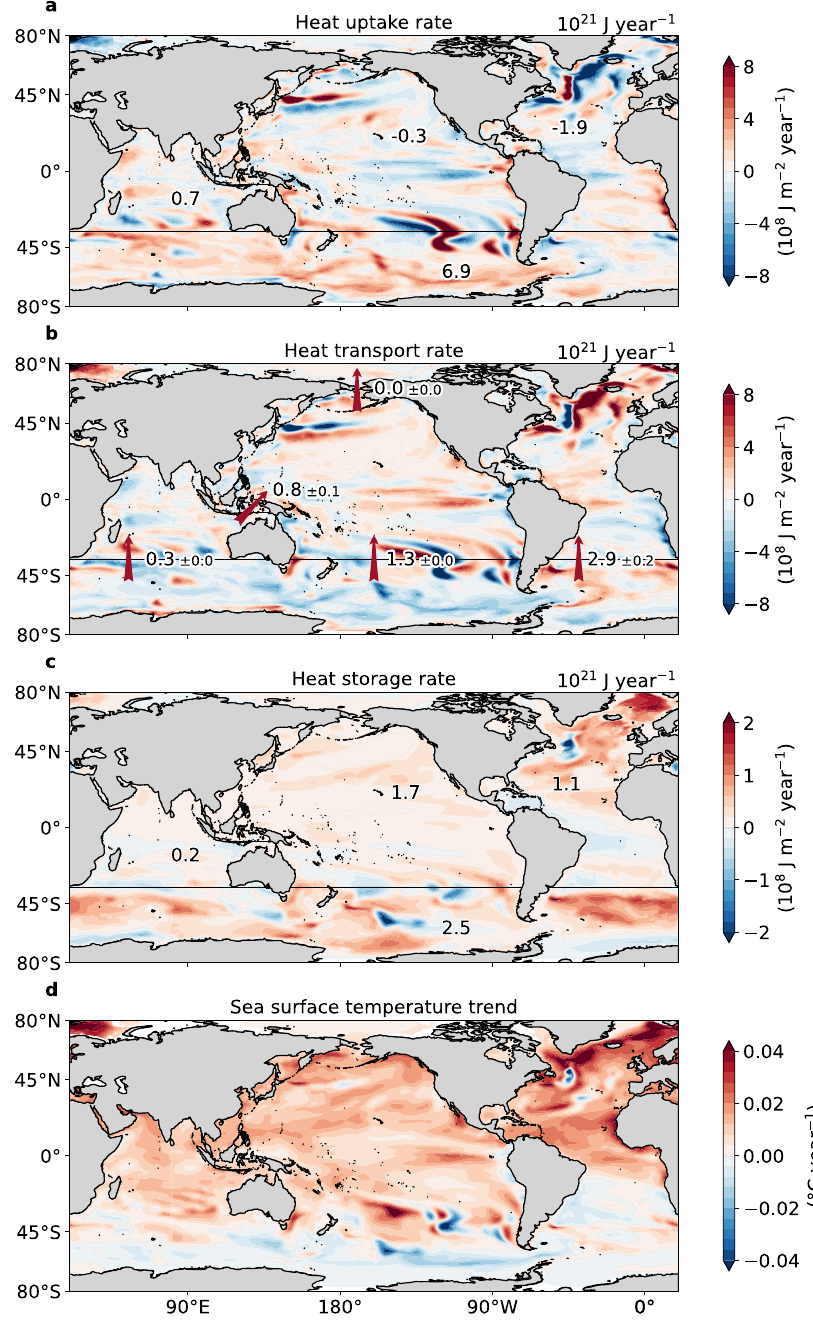
Fig. 3 | Spatial distribution of ocean heat uptake, transport, storage and sea surface temperature trends over 1972 – 2017 in the full forcing simulation (where all atmospheric forcing fi elds evolve over time). a Time integrated net surface heat fl ux anomalies (10 8 J m − 2 year − 1 ) with positive heat uptake de fi ned as into the ocean. The basin-wide values (10 21 J year − 1 ) show the total area integrated trends over a particular ocean basin with the boundaries set by the black lines across the Southern Ocean, the Indonesian Through fl ow, the Bering Strait and the continental land masses. The Southern Ocean ends at 36°S, the Bering Strait is at 65°NandtheIndonesianThrough fl owisde fi nedbetweenJava,NewGuinea(105°W to 134°W) at 3°S and the Australian continent (20°S to 6°S) at 137°E. The Atlantic